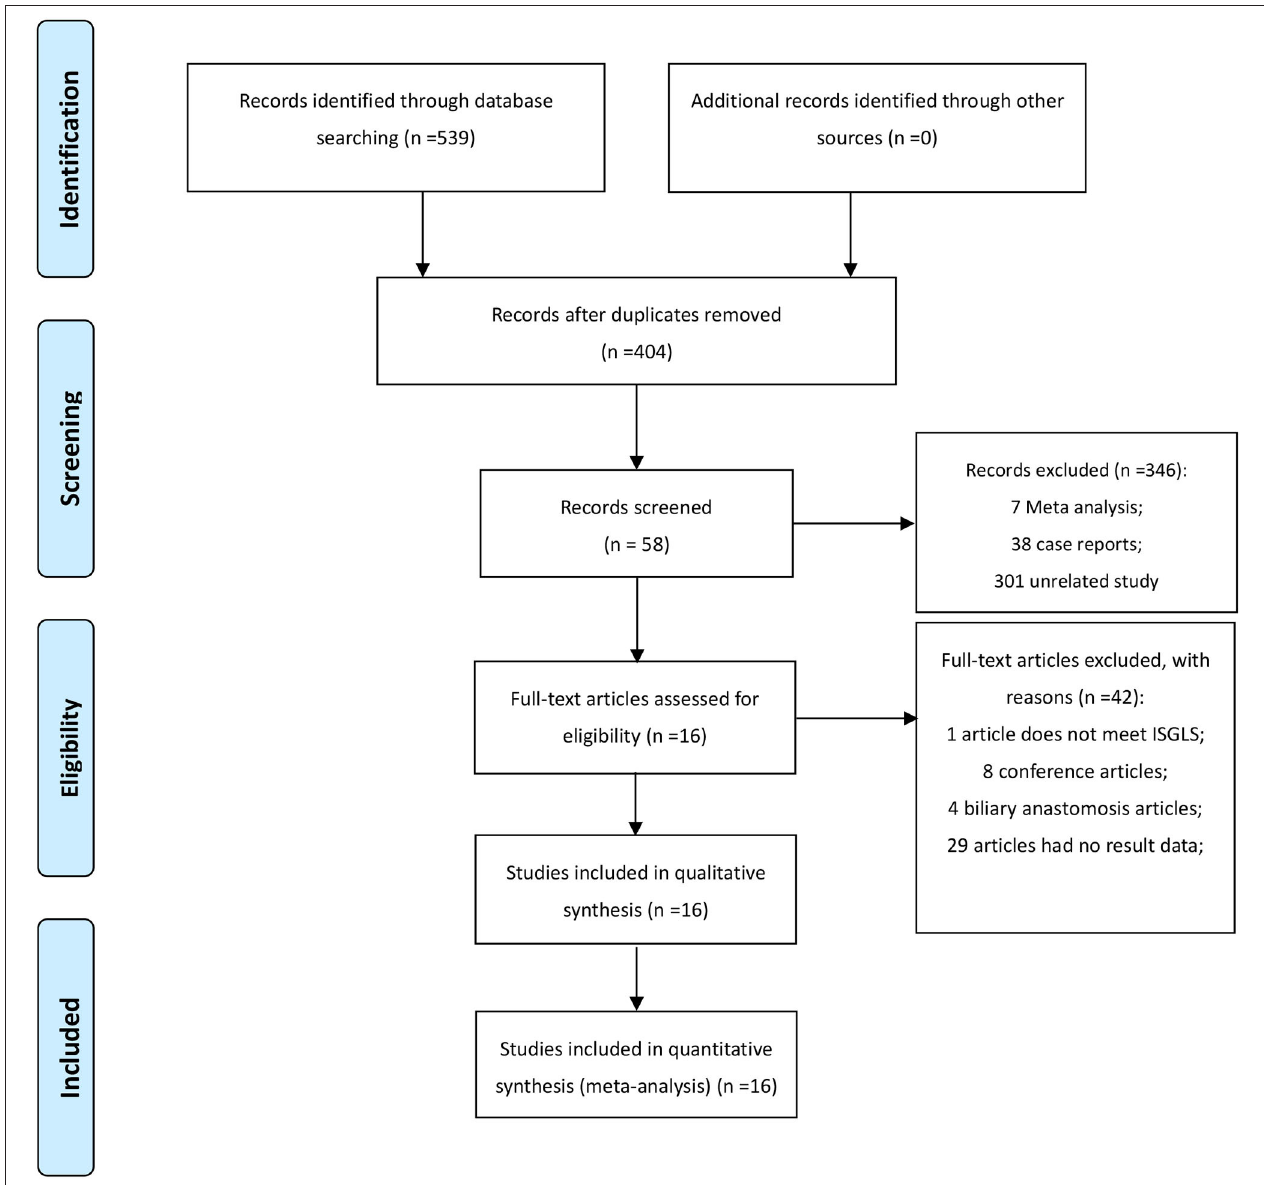
FIGURE 1 | PRISMA flow chart of search strategy and research